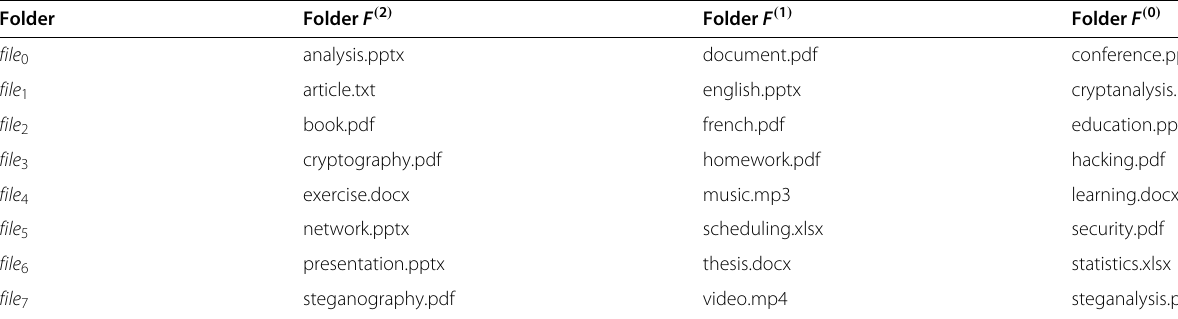
Table 3 Set of files distributed by folder in the cloud environment